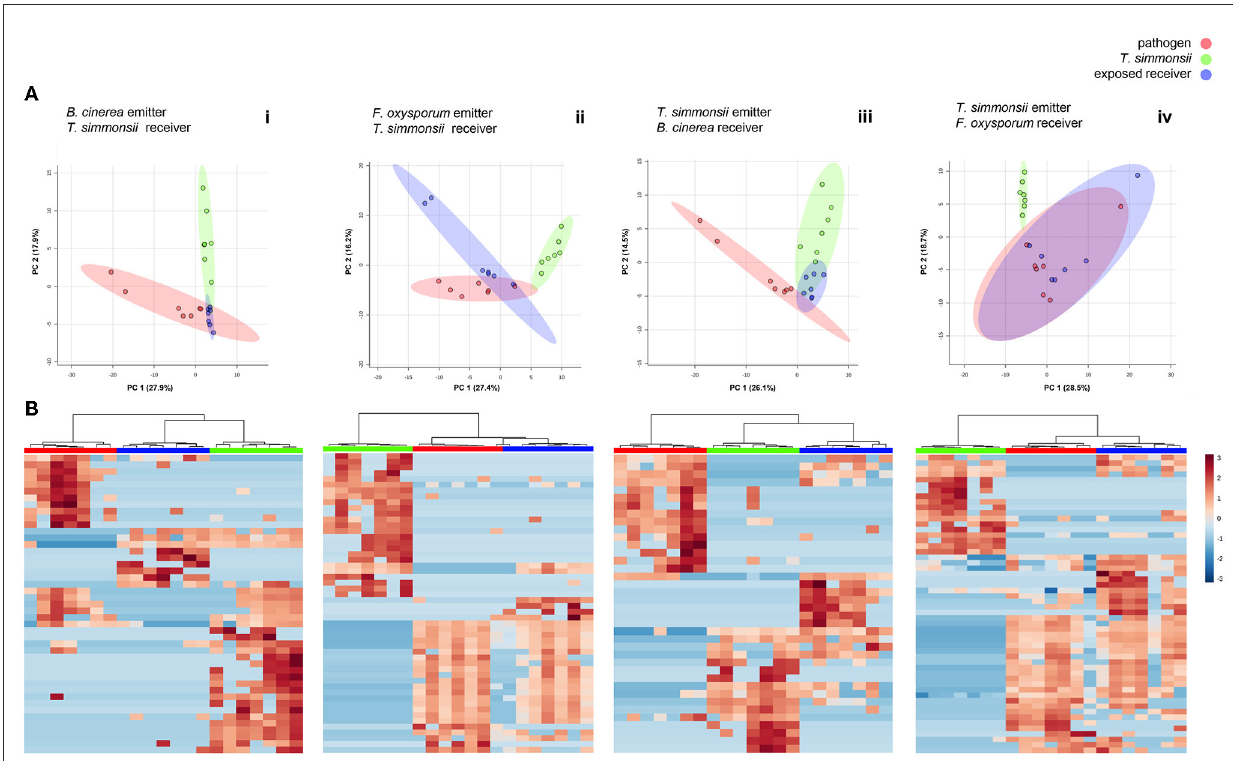
FIGURE3 Differences in volatilome profiles between volatilomes of fungi incubated alone vs. exposed to their interactor’s volatilome in a dual microcosm setup ( n = 7). (A) Principal Component Analysis (PCA) plots of volatilome profiles; each dot represents one volatilome sample and each circle represents the 95% confidence interval. (B) Heatmap representing the hierarchical clustering of volatiles with significantly modified abundance between the different groups. Each line represents a mass feature (volatile compound) and each column represents a sample. The color indicates the normalized intensity and the dendrograms display the similarity based on the Pearson